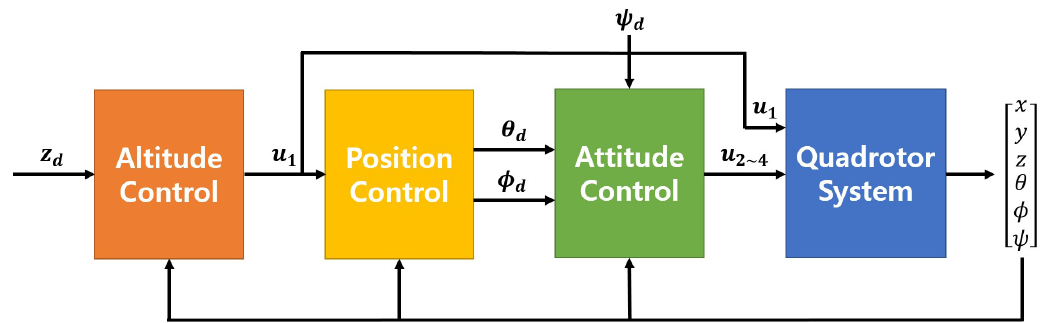
Figure 2. The overall control scheme for the quadrotor position